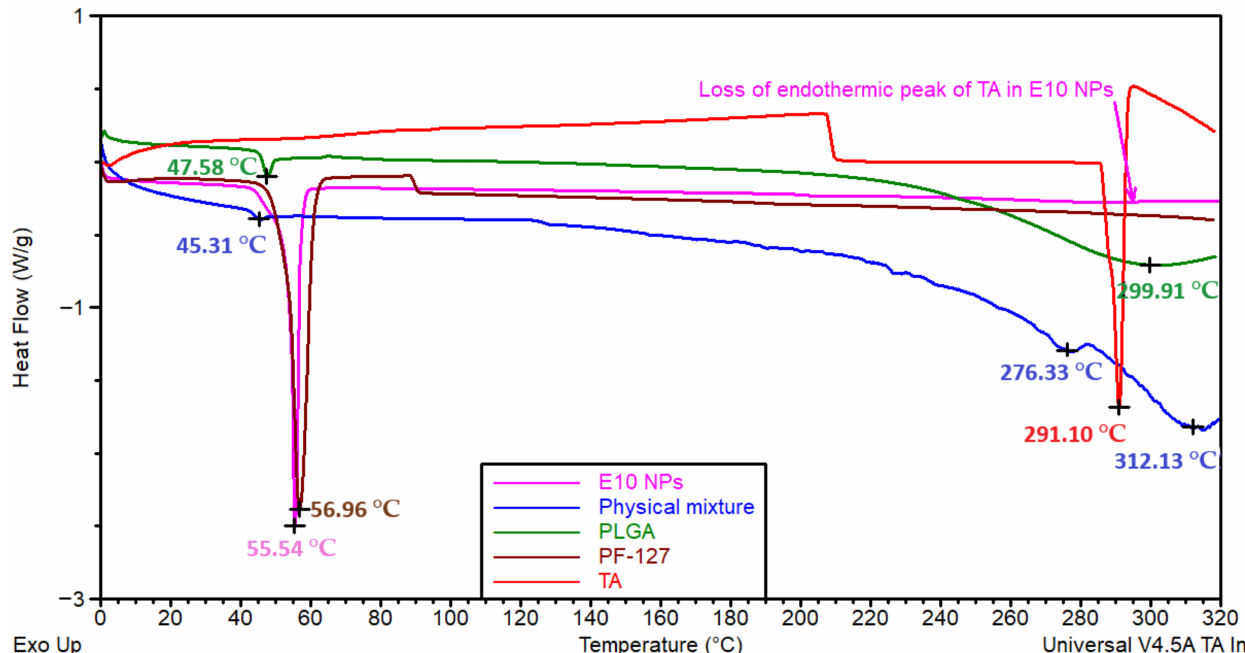
Figure 6. Differential scanning calorimetry (DSC) thermograms of physical mixture, individual components (TA, PLGA and PF-127) and PLGA NPs